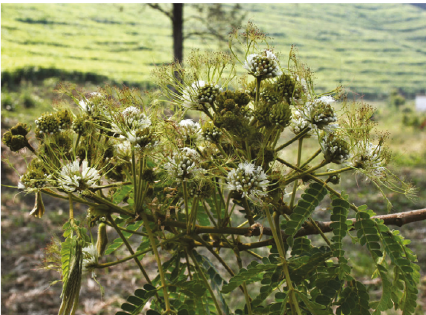
Figure 1: Albizia adianthifolia , a branch showing leaves and flowers (photo: MA